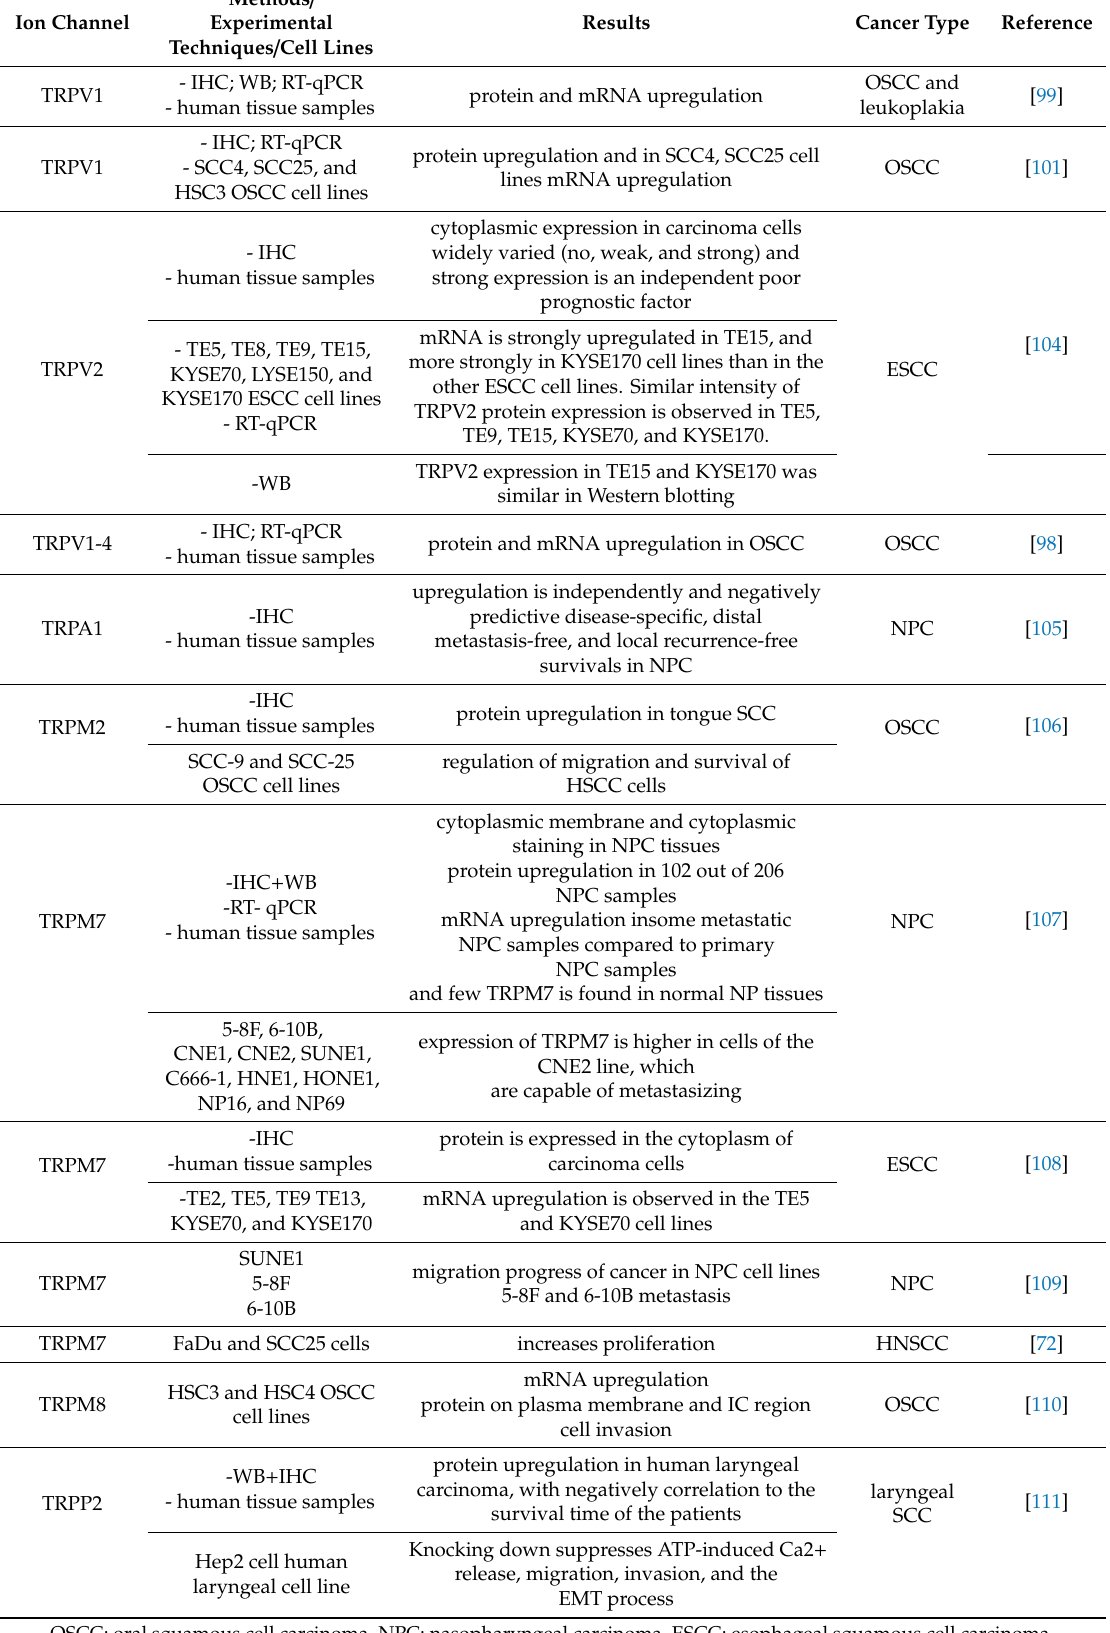
Table 1. Increased expression of Transient Receptor Potential (TRP) channels in human head-and-neck cancer samples and experimental